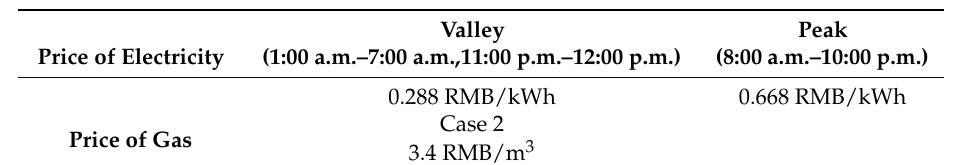
Table 3. Energy tariff in Case 2.